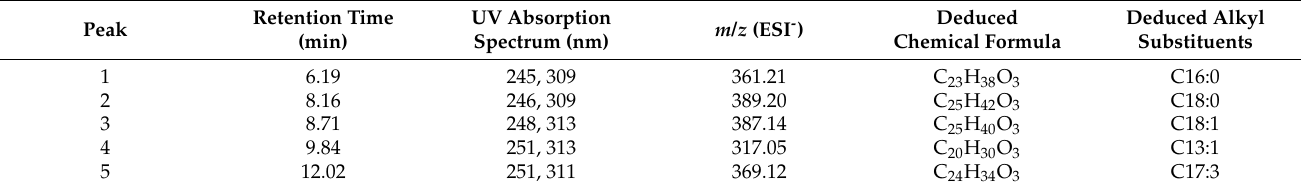
Table 4. Summary of the five deduced newly identified ginkgolic acids in ginkgo wine. Retention Time UV Absorption Peak (min) Spectrum (nm)